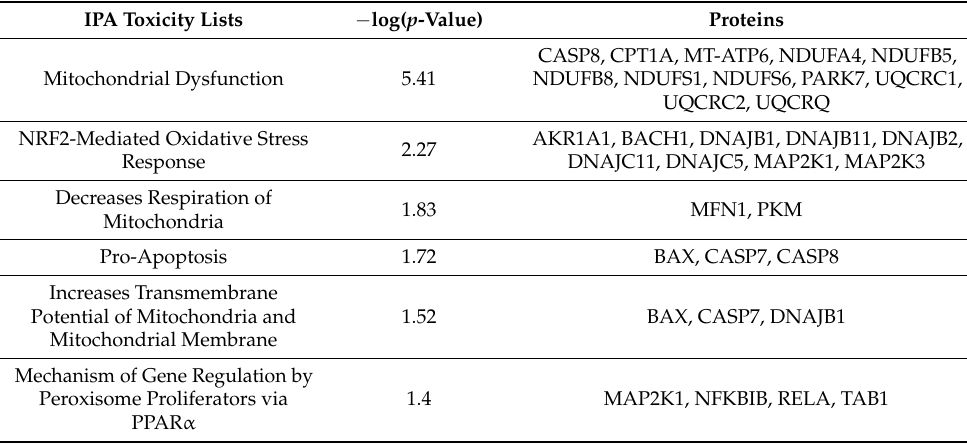
Table 5. Toxicity lists for the 10 µ g/mL of Nicotine vs. PBS